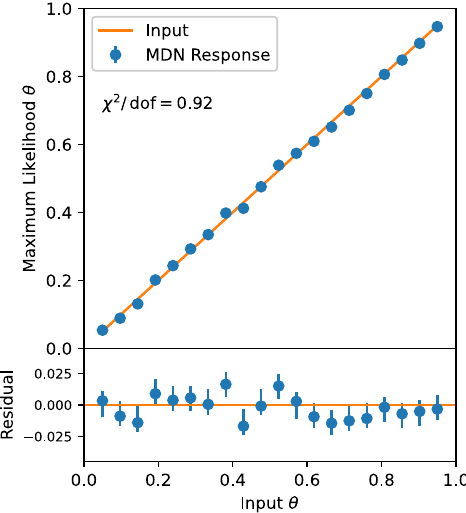
Fig. 7 Comparison of the true value of the parameter θ and the MLE estimate determined for a dataset generated at that θ over the range θ ∈ [ 0 , 1 ] . The errors shown are those obtained by applying Wilks’ theorem to the posterior density. No bias is observed and the error estimates meet